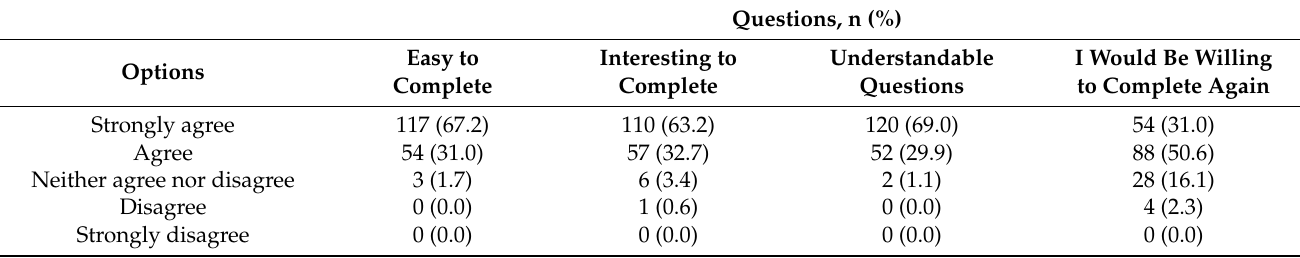
Table 8. Responses of the study participants to the usability rating questionnaire for the e-12HR